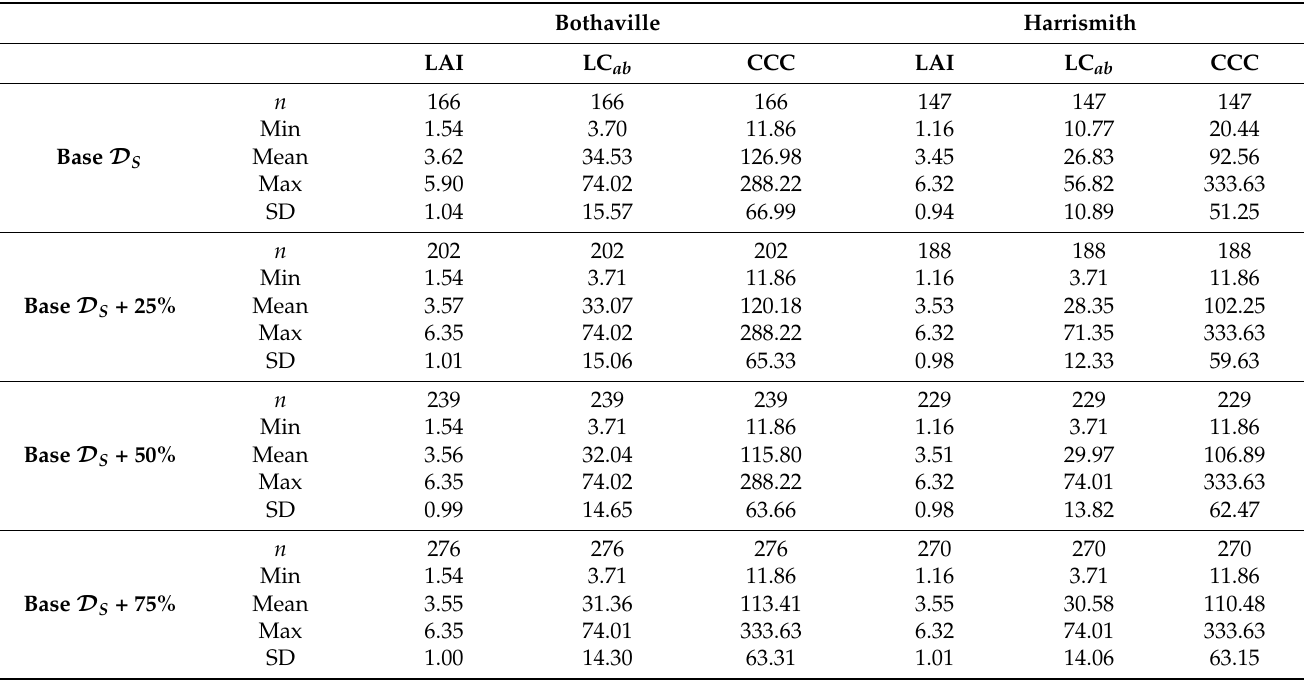
Table 1. Descriptive statistics of LAI (m 2 m − 2 ), LCab ( µ g cm − 2 ) and CCC ( µ g cm − 2 ) training samples for Source site (i.e., Base D S ) different transfer scenarios, i.e., Base D S + 25%, Base D S + 50%, and Base D S +